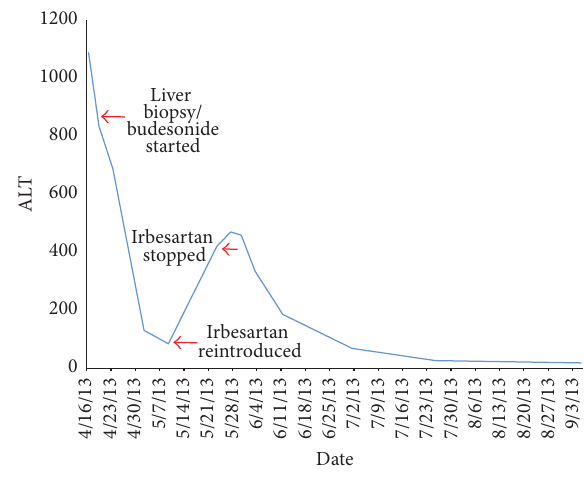
Figure 1: Timeline of ALT changes.